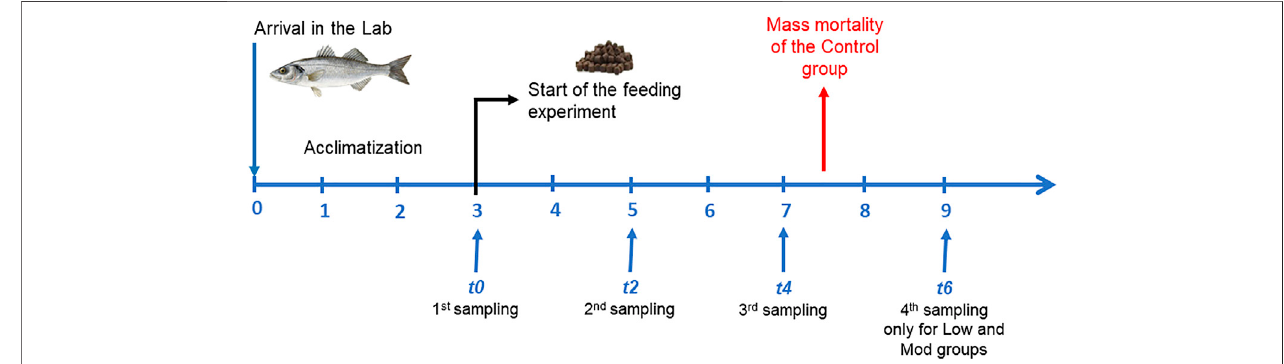
FIGURE 1 | Experimental design. Juvenile European seabass, Dicentrarchus labrax (body mass, 98 ± 17 g; standard length, 20 ± 2 cm at t 0 , n = 15) were simultaneously grown under different dietary conditions during 9 weeks (three of acclimatization t 0 and six of feeding experiment, t 2 to t 6 ).